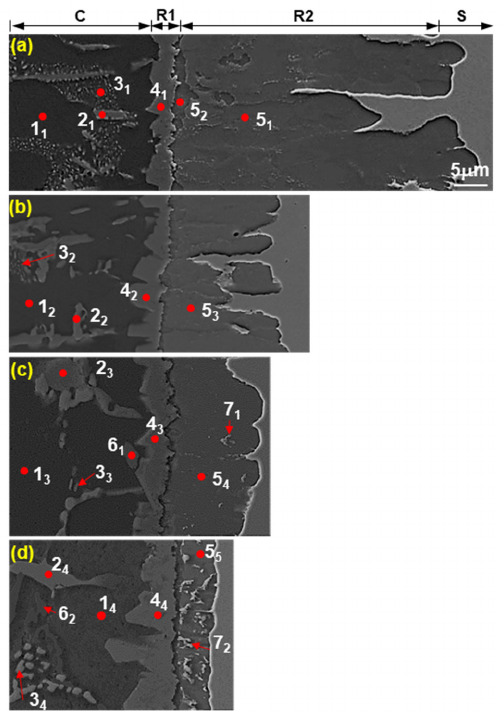
Figure. 2. SEM micrographs of specimens hot dipped at 690 °C for 120 s for varying amount of Si ◦ C for 120 s for varying amount of Si added added based on the Al–7Ni wt % coating: ( a ) 0 wt % Si, ( b ) 1 wt % Si, ( c ) 2 wt % Si, ( d ) 6 wt % Si. Figure 2. SEM micrographs of specimens hot dipped at 690 based on the Al–7Ni wt % coating: ( a ) 0 wt % Si; ( b ) 1 wt % Si; ( c ) 2 wt % Si; ( d ) 6 wt %